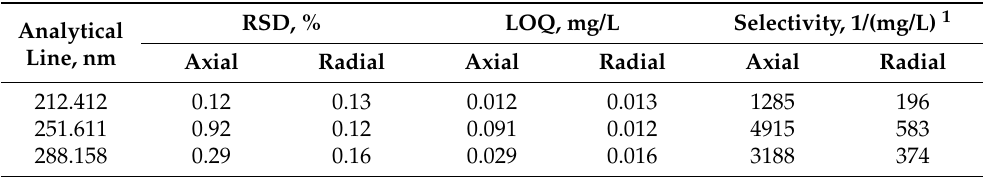
Table 2. Comparison of the radial and axial ICP-OES